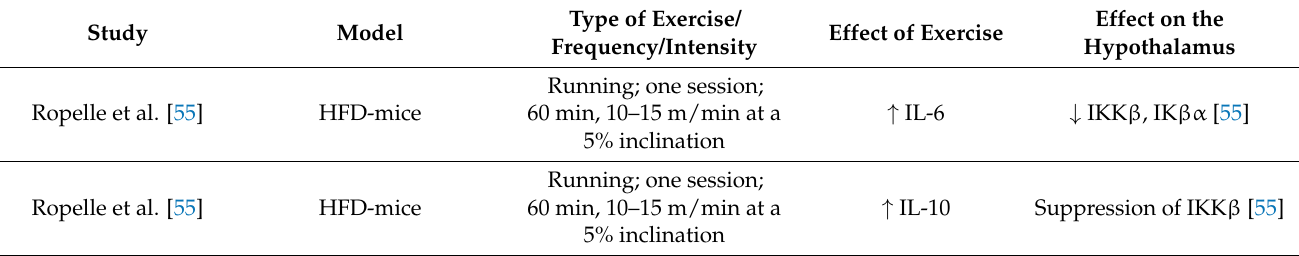
Table 2. Effect of exercise-modulated mediators on the hypothalamus of animals and